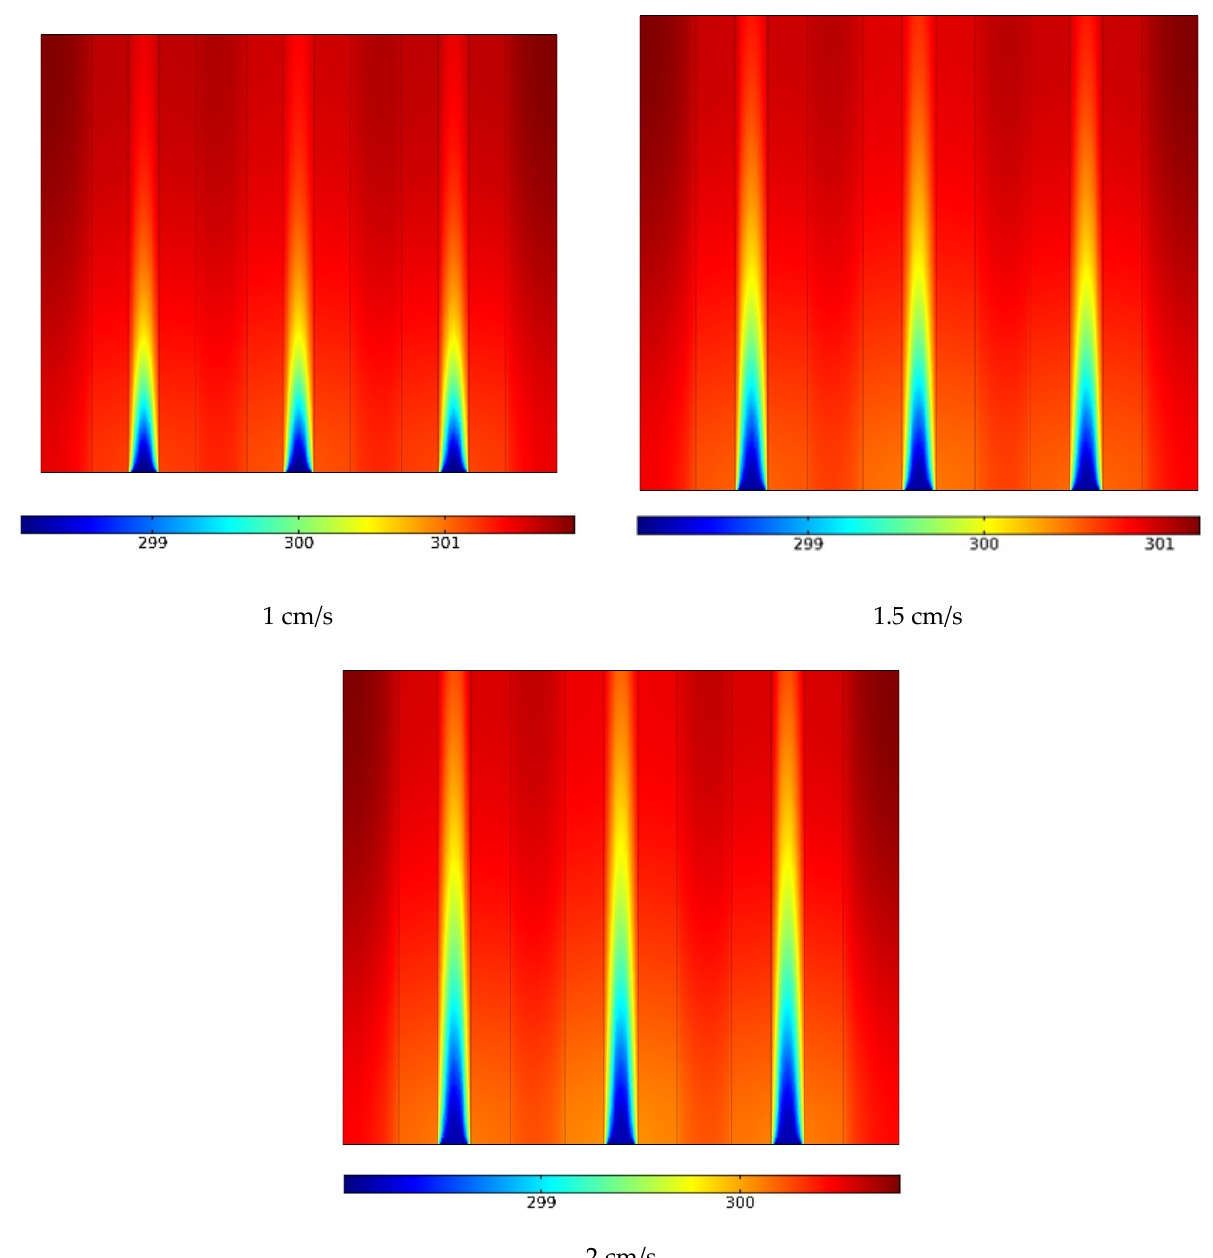
Figure 7. The temperature contour at three different velocities in the solar panel’s horizontal surface.